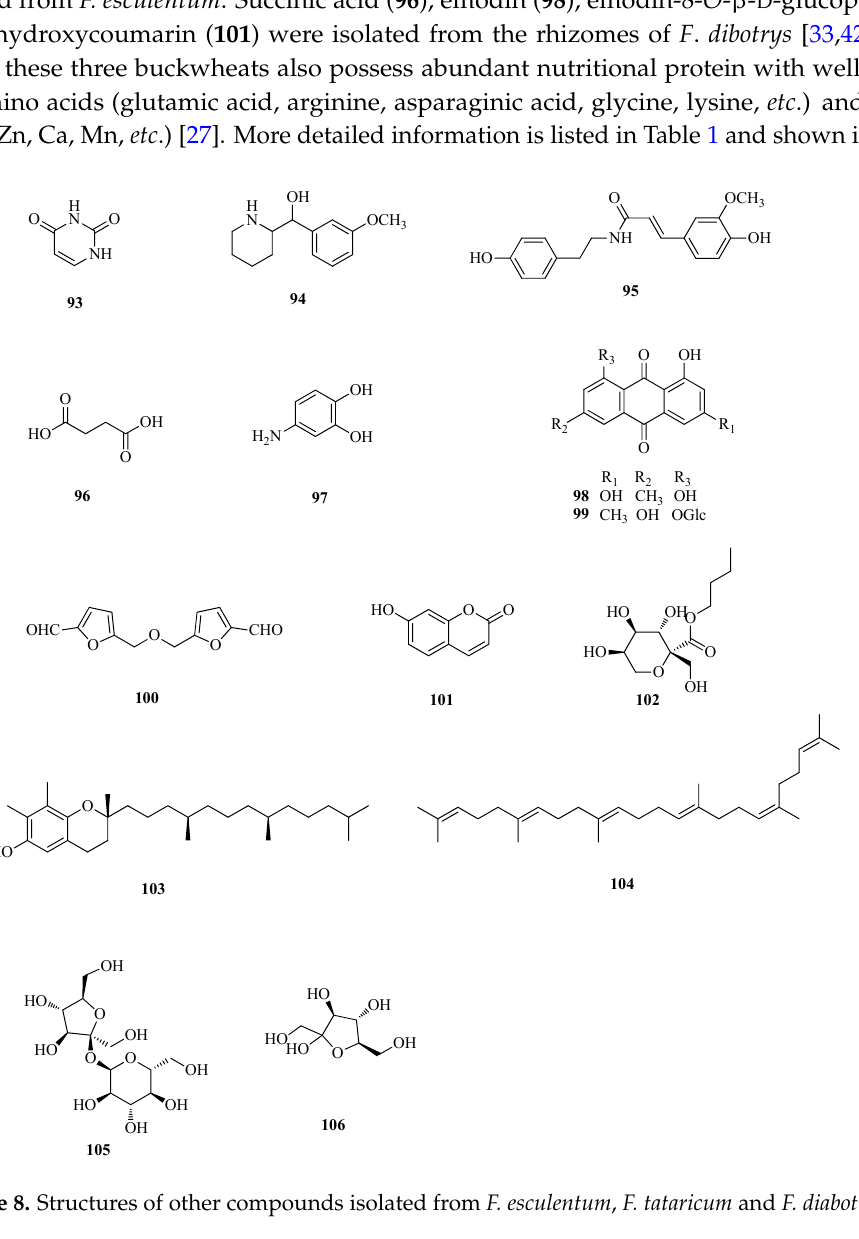
Figure 8. Structures of other compounds isolated from F. esculentum , F. tataricum and F. diabotrys .